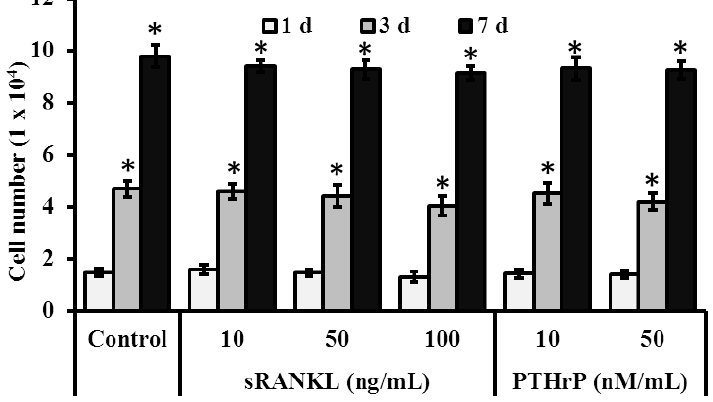
Figure 3. E ff ect of soluble receptor activator of nuclear factor- κ B ligand (sRANKL) and parathyroid Figure 3. Effect of soluble receptor activator of nuclear factor- κB ligand ( sRANKL) and parathyroid hormone-related peptide (PTHrP) on proliferation of MSCs. * p < 0.05 vs. 1 hormone-related peptide (PTHrP) on proliferation of MSCs. *p < 0.05 vs. 1 day.